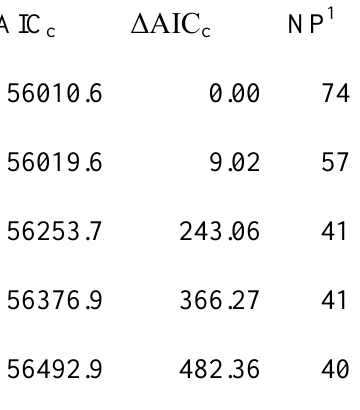
Table. A3.1. Candidate models describing survival probability of juvenile (Juv) and adult Canada geese banded on Akimiski Island, NU, 1993 to 2010, using the Brownie et al.